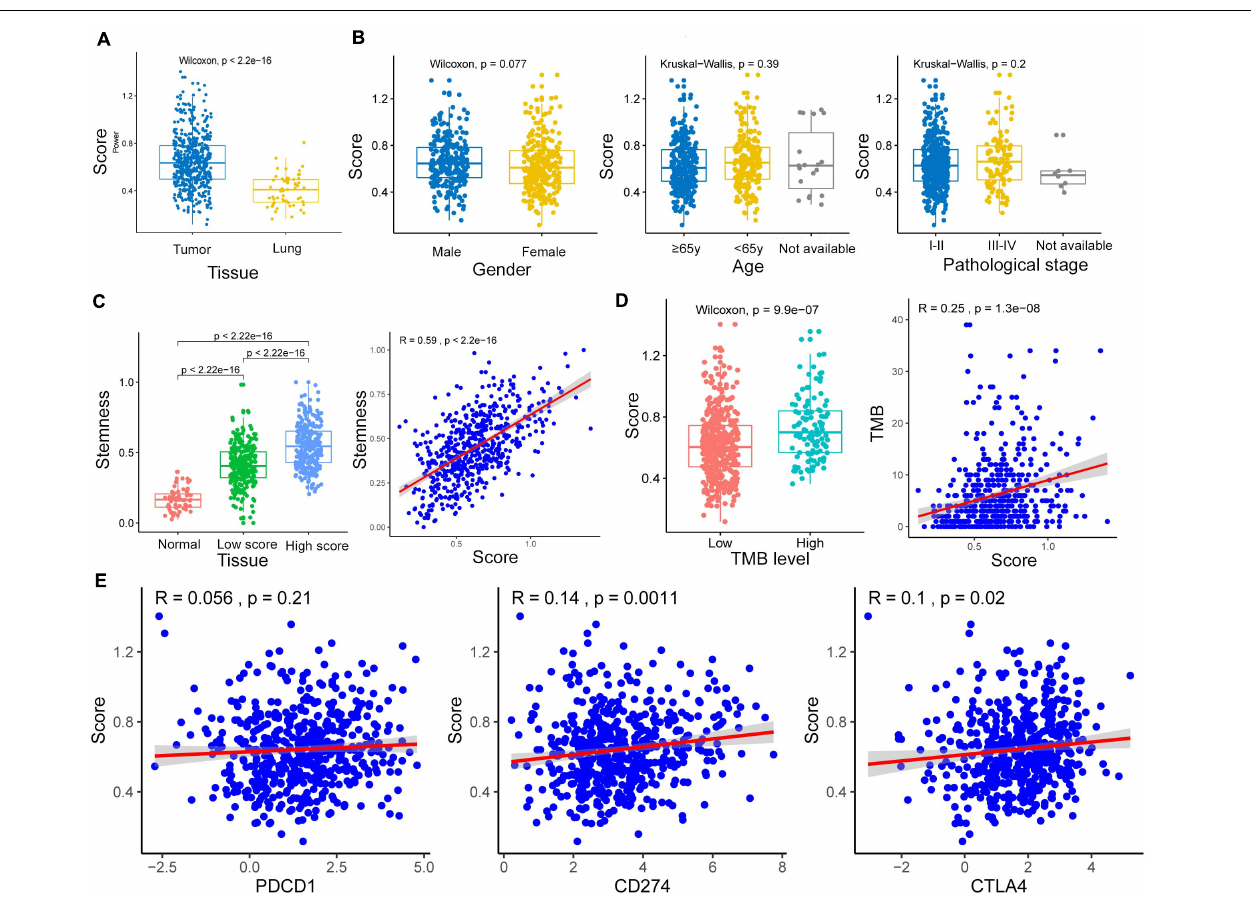
FIGURE 3 | Associations of the m6A-related gene set variation score (m6A-GSVS) with clinicopathological features, stemness, tumor mutational burden (TMB), and expression of three immune checkpoints. (A) The m6A-GSVS was higher in lung adenocarcinoma than in healthy lung tissues. (B) The m6A-GSVS did not differ significantly with sex, age, or pathological stage. (C) The m6A-GSVS correlated strongly with stemness. (D) The m6A-GSVS correlated with TMB. (E) The m6A-GSVS was associated with the expression of three immune